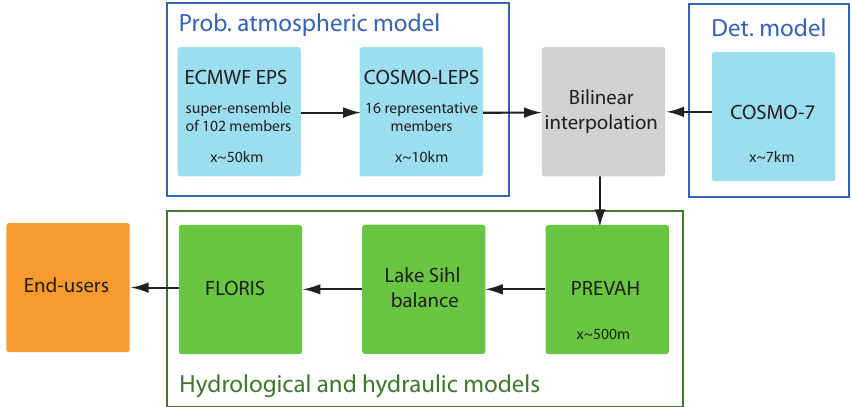
Fig. 3. Flowchart of the prediction chain, illustrating in particular that probability (prob.) and deterministic (det.) atmospheric forecasts are used to force the hydrological model. The horizontal grid spacing of the models is denoted by x and indicates that atmospheric forecasts are downscaled throughout the HEPS. A detailed description of the model chain can be found in Sects. 2.1 and